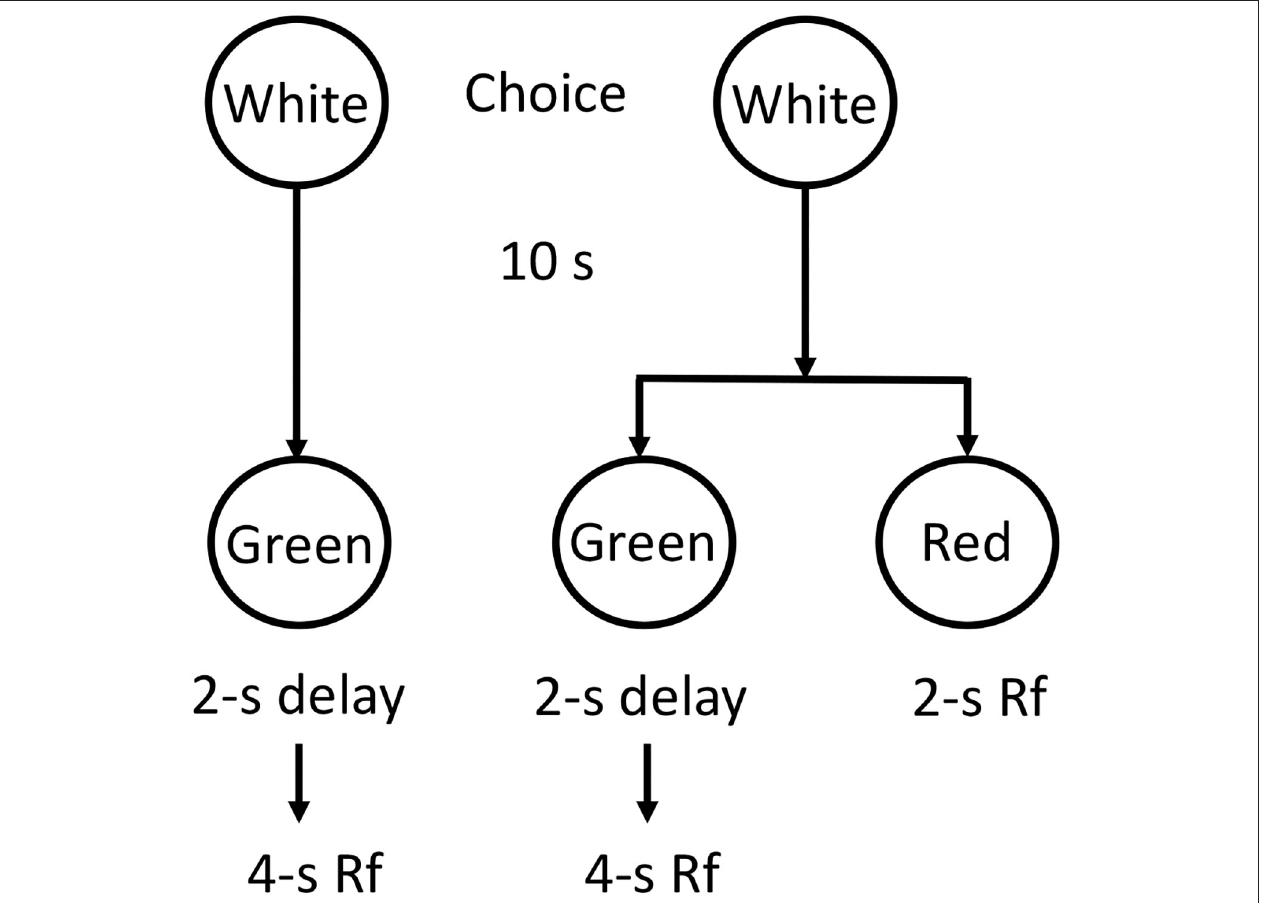
FIGURE 2 | Design of the Rachlin and Green (1972) experiment. Given an immediate choice between Green (2-s delay and 4-s reinforcement) and Red (immediate 2-s reinforcement) pigeons preferred Red. However, given an initial choice between Green alone or a choice between Green and Red, pigeons preferred Green alone. It looks like they make a “commitment” to avoid the “temptation” to choose